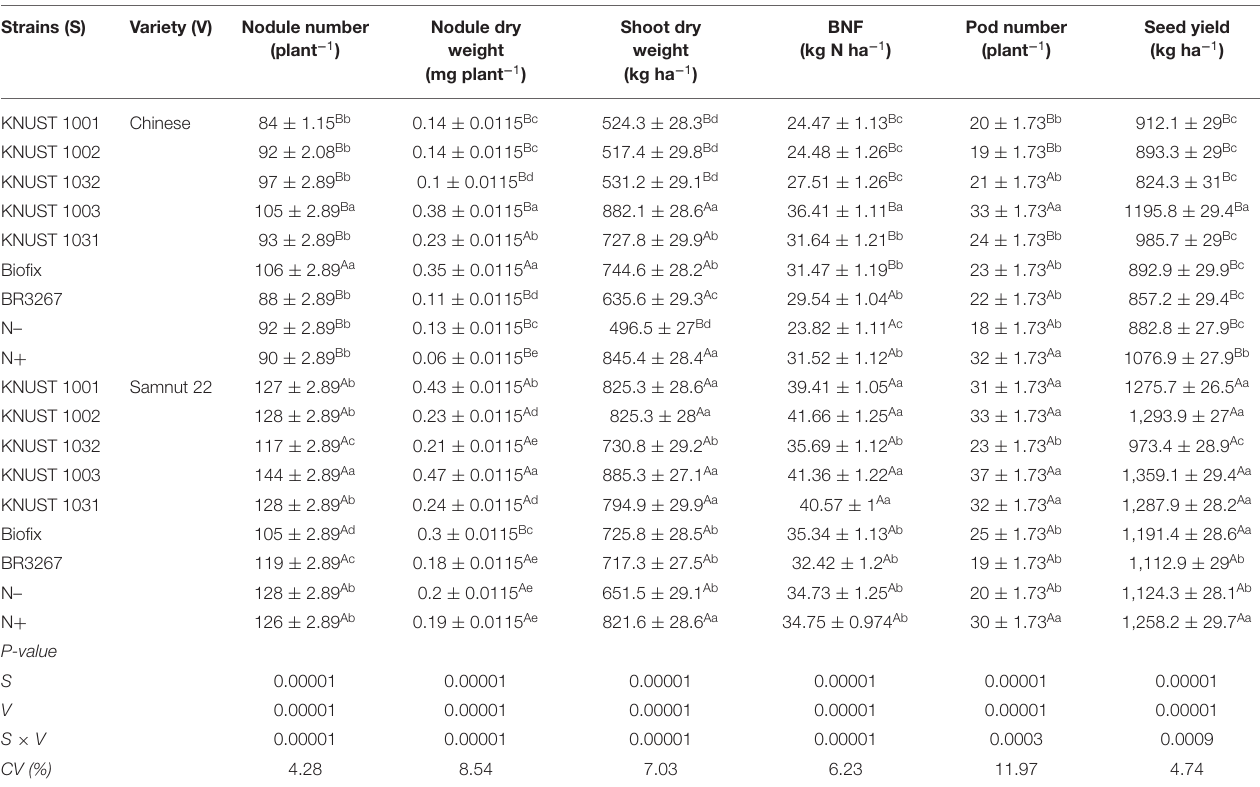
TABLE 3 | The response of groundnut to rhizobia inoculation and mineral N application at Binduri. Strains (S) Variety